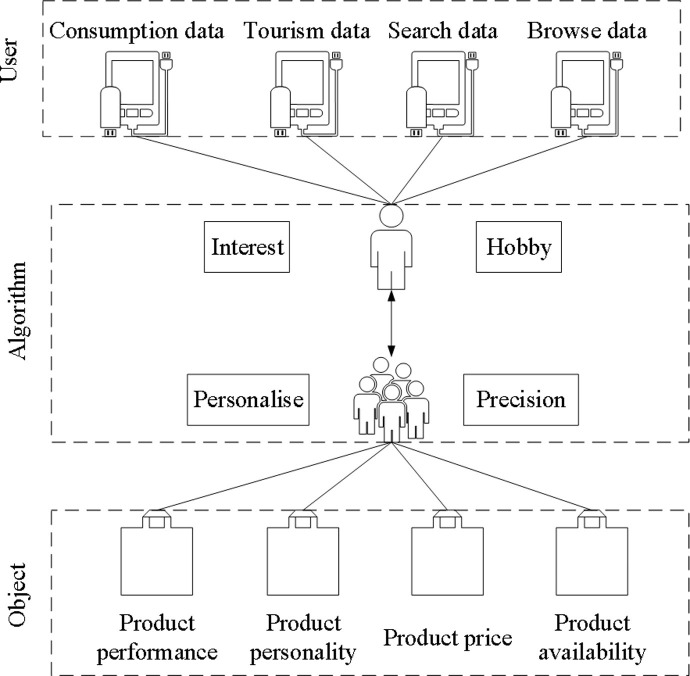
The structure of a tourism collaborative recommendation system.